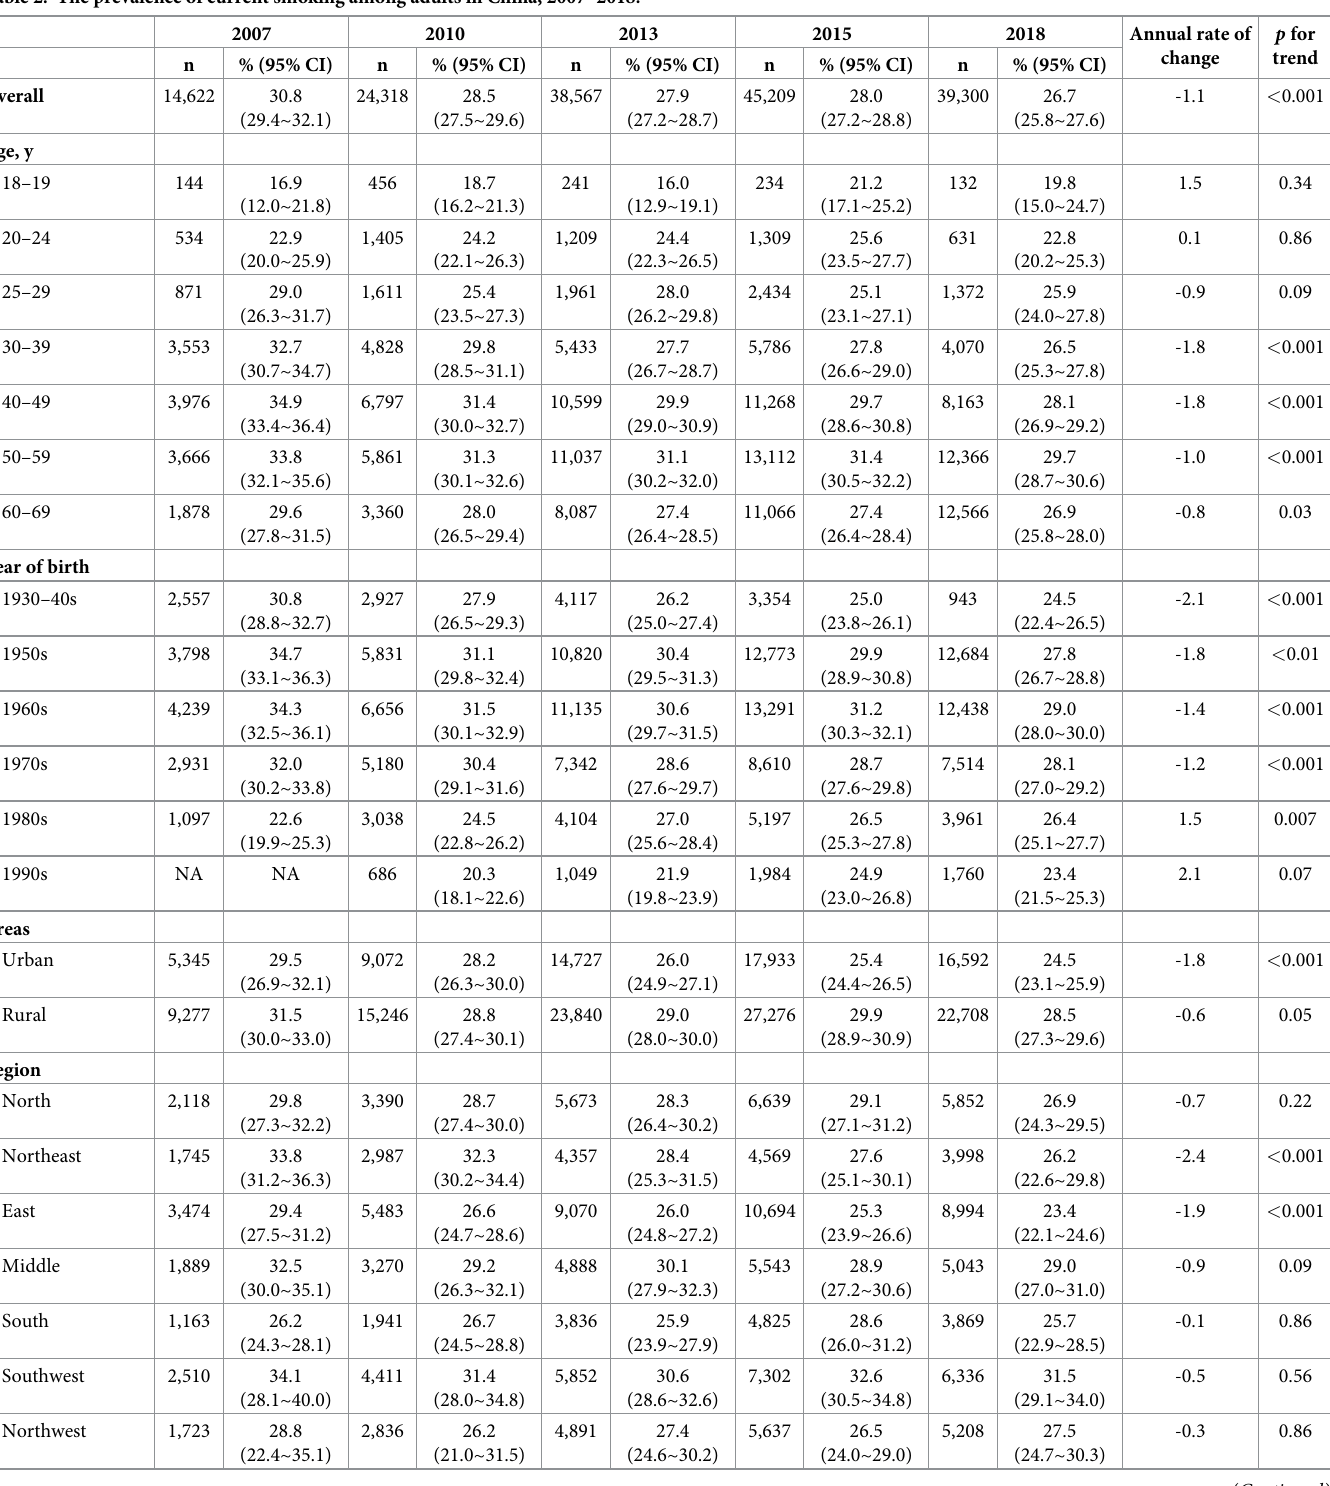
Table 2. The prevalence of current smoking among adults in China,